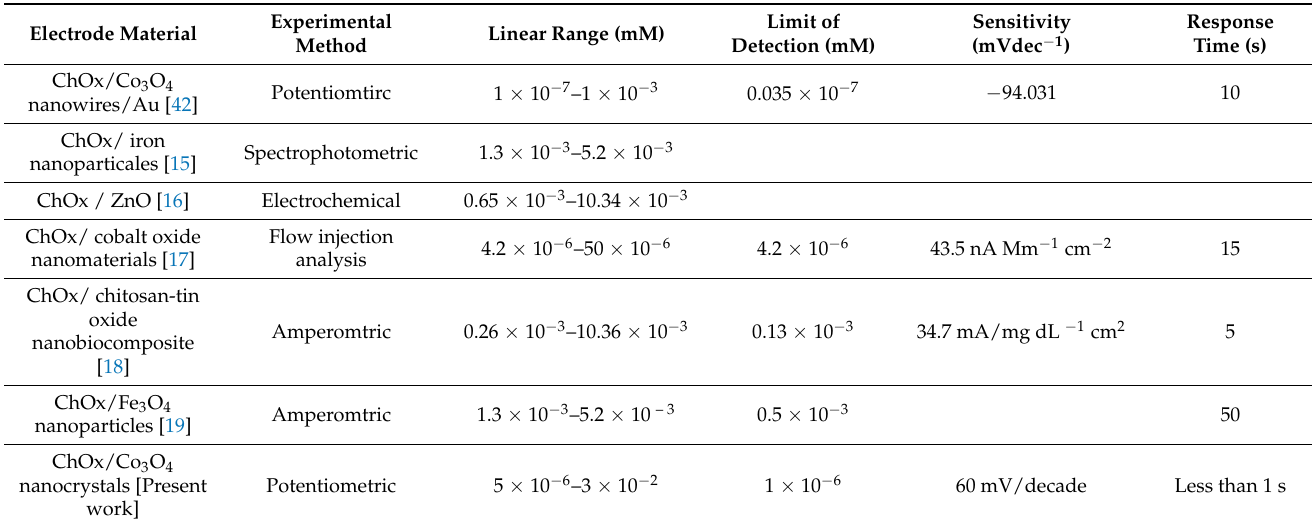
Table 4. Comparative analysis of cholesterol oxidase-immobilized Co 3 O 4 nanocrystals with re- ported